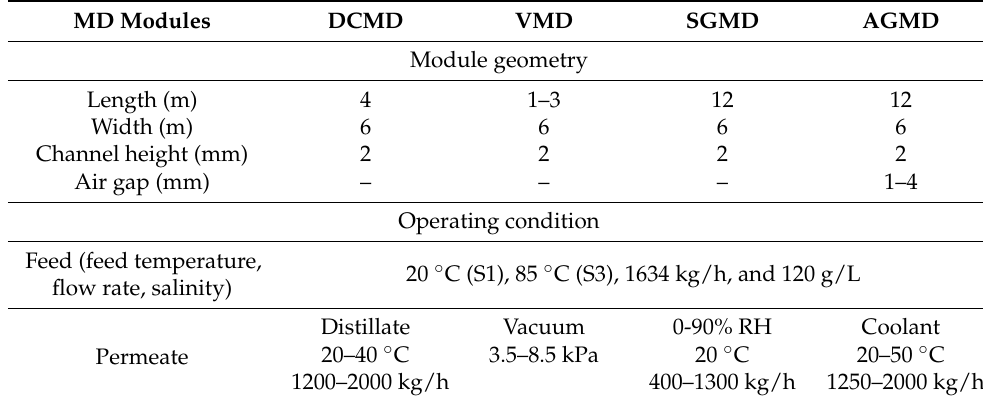
Table 7. Geometry of the modules and operating of single-stage MD desalination